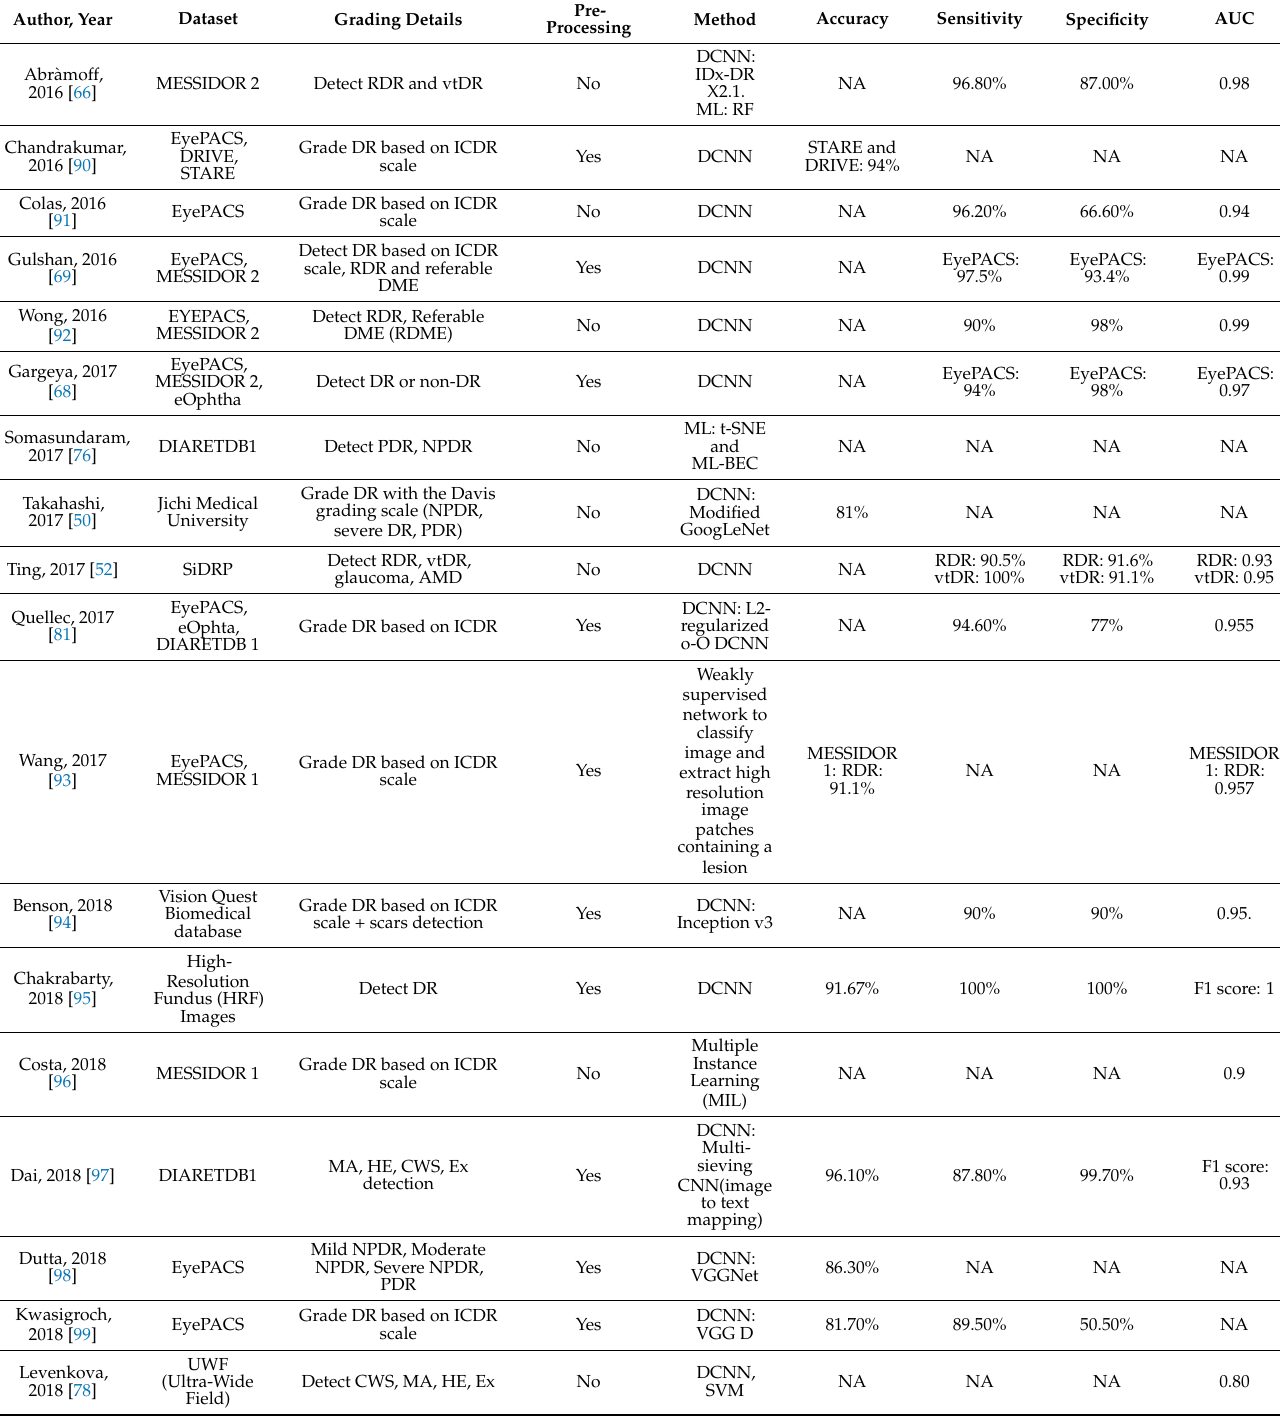
Table 2. Classification-based studies in DR detection using fundus